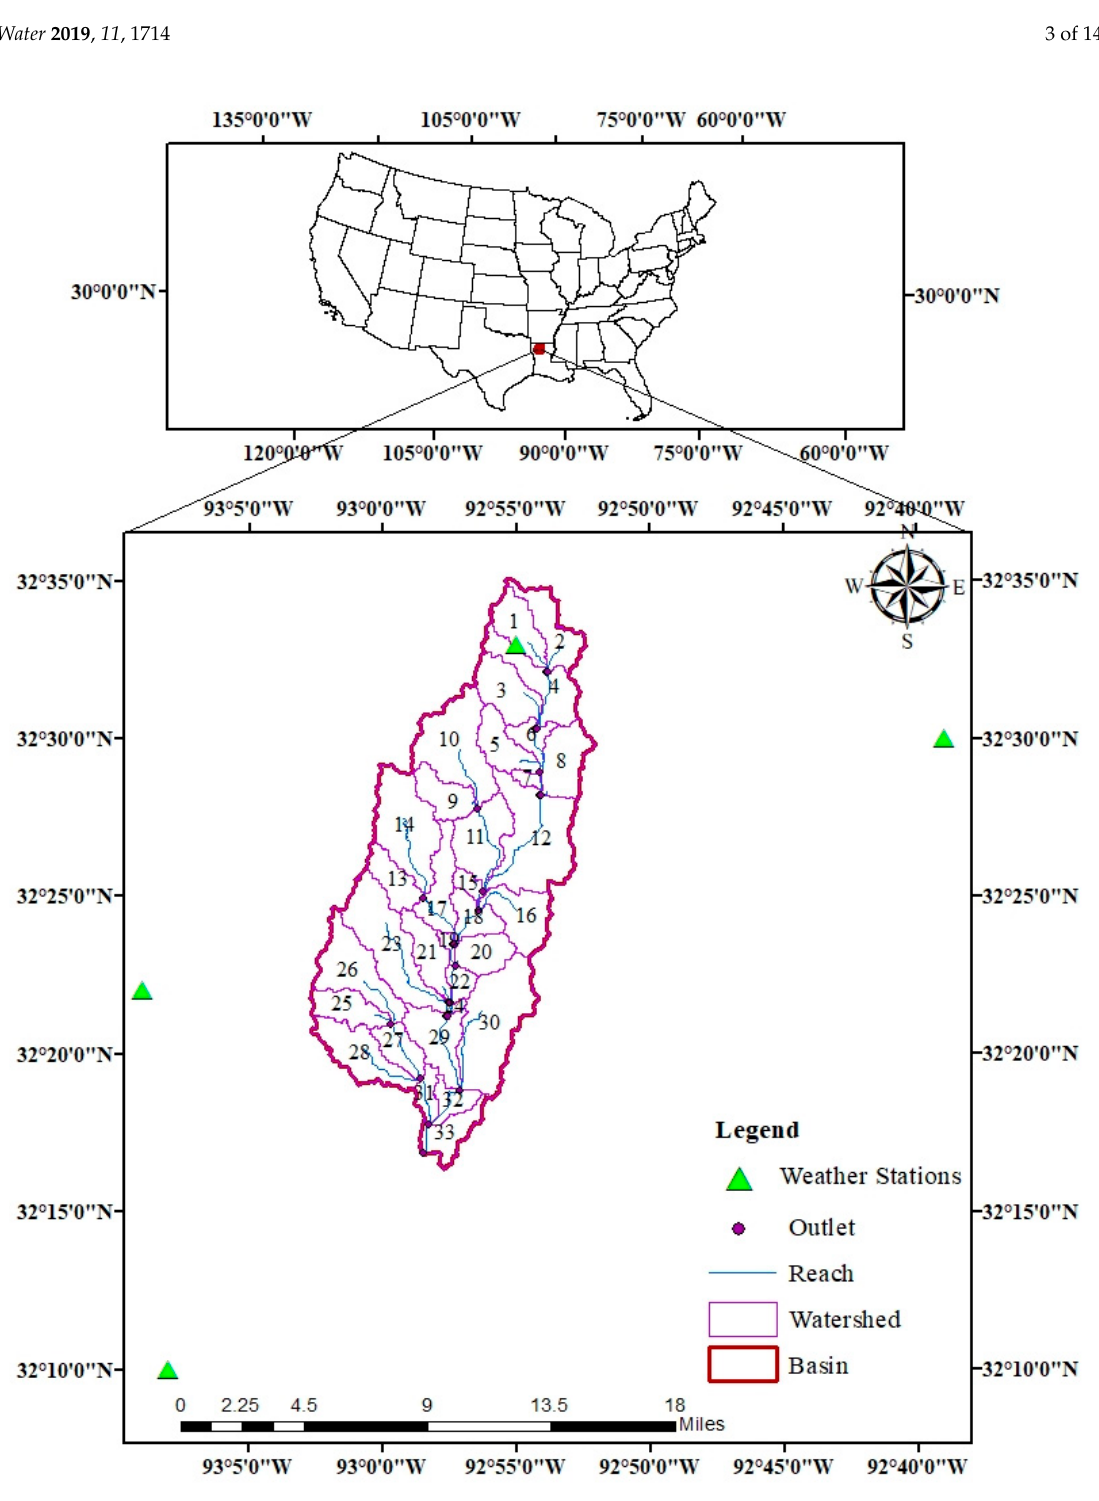
Figure 1. Location of the Saline Bayou Watershed, Louisiana, USA.